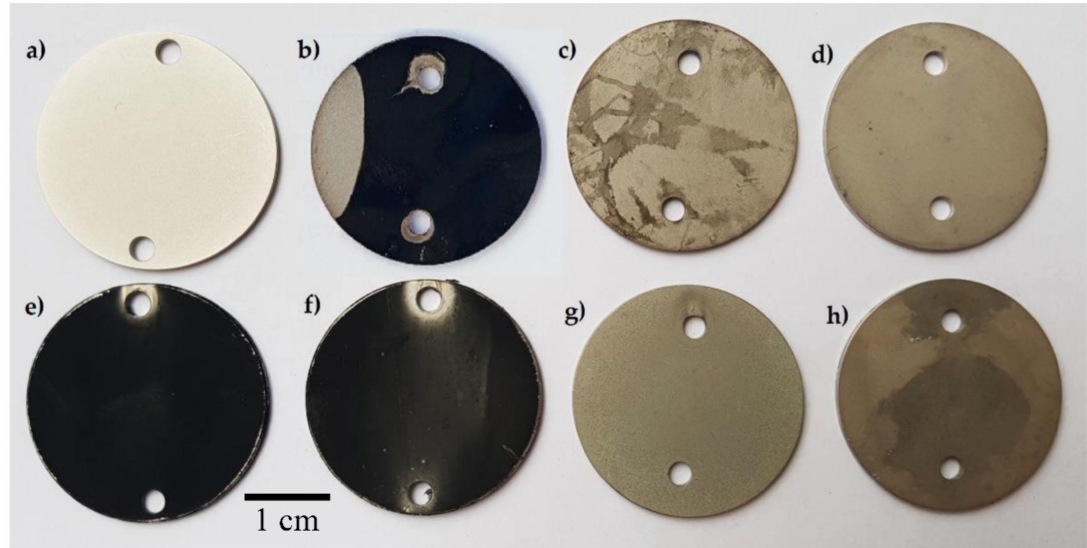
Figure 2. Nickel-plated brass samples after black coating deposition following the procedures in Table 1. ( a ) sample before deposition (substrate), ( b ) procedure 1, ( c ) procedure 2, ( d ) procedure 3, ( e , f ) procedure 4, ( g ) procedure 5, ( h ) procedure